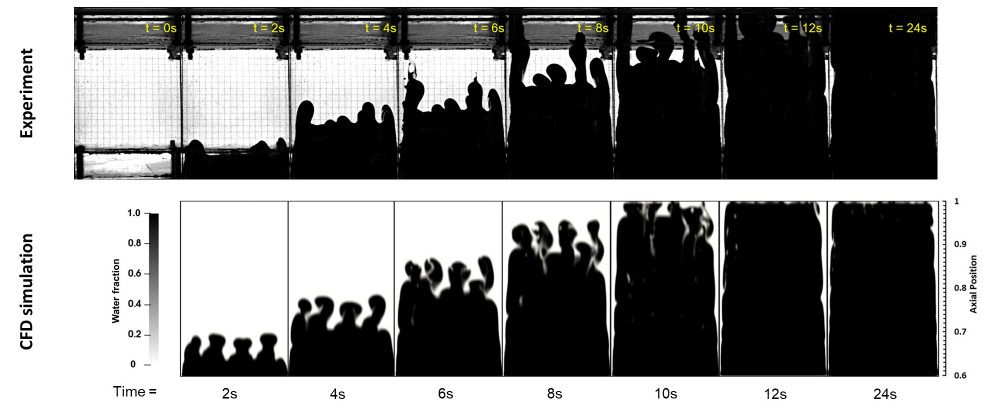
Figure 7. Updated CFD simulation ( bottom ) of interface evolution of water displacing 0.075 wt.% xanthan gum solution with an initially perturbed